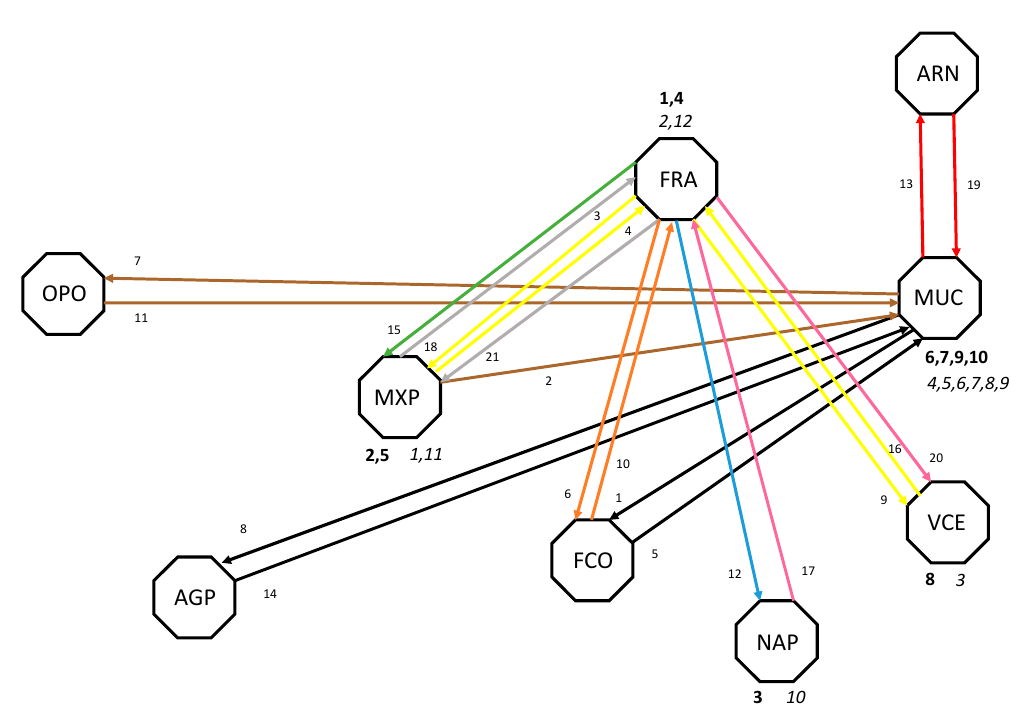
Figure 3. Crew pairing diagram for crews after rescheduling crew routes.